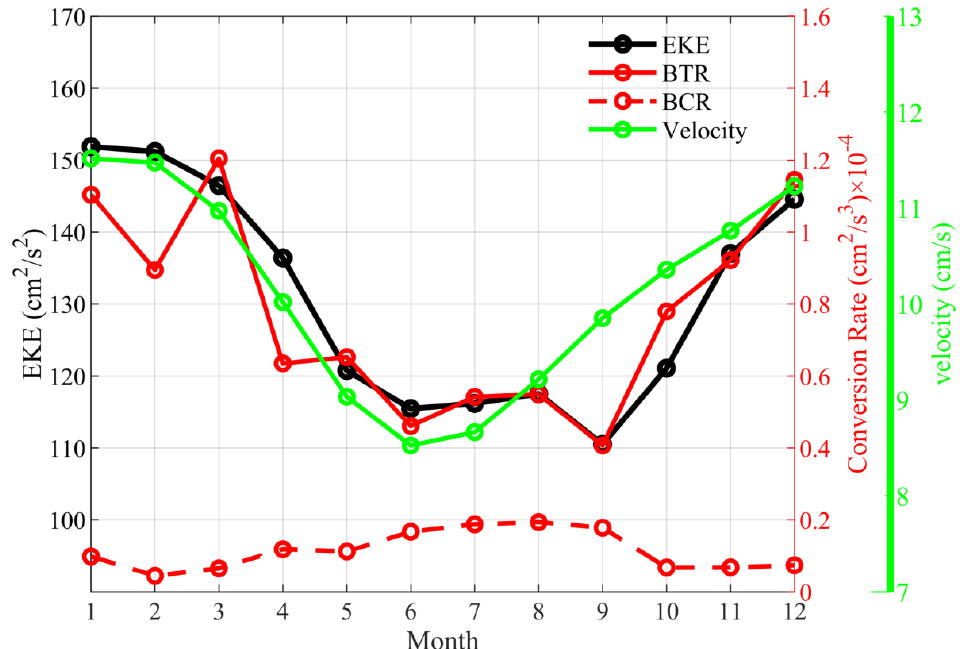
Figure 9. Monthly mean climatological eddy kinetic energy (EKE, black line), barotropic conversion rate (BTR, red solid line), baroclinic conversion rate (BCR, red dash line) in the upper 500 m averaged over (150–160° E, 25–38° S). Green line denotes the monthly mean climatological variations of the southward velocity in the upper 500 m averaged over (150–155° E, 25–38° S), which has been 180-day low-pass filtered.